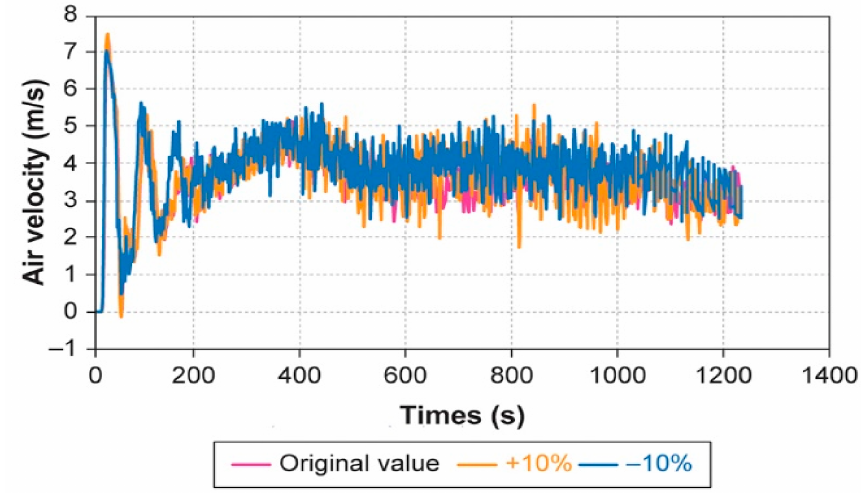
Figure 13. CO yield effects on air